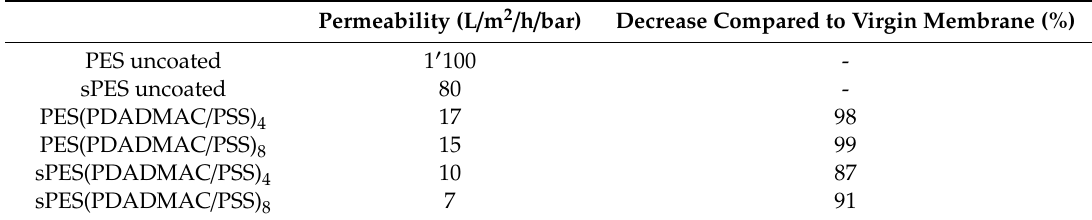
Table 2. Permeability of coated